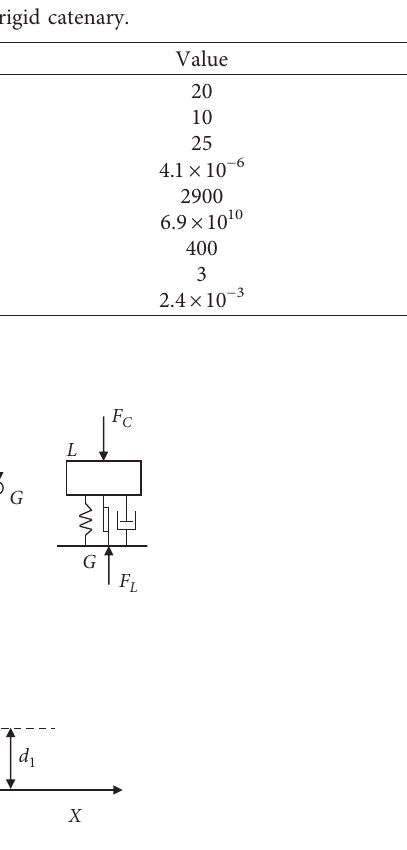
Figure 2: Simplified vertical-structure simulation model of pantograph. Table 2: Simulation model parameters for